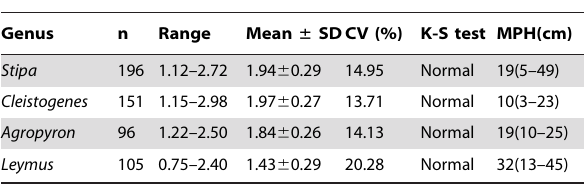
Table 2. Statistics of plant root/shoot ratios of four dominant genera ( Stipa , Cleistogenes , Agropyron , and Leymus ) across a 2500-km long transect in northern China’s temperature